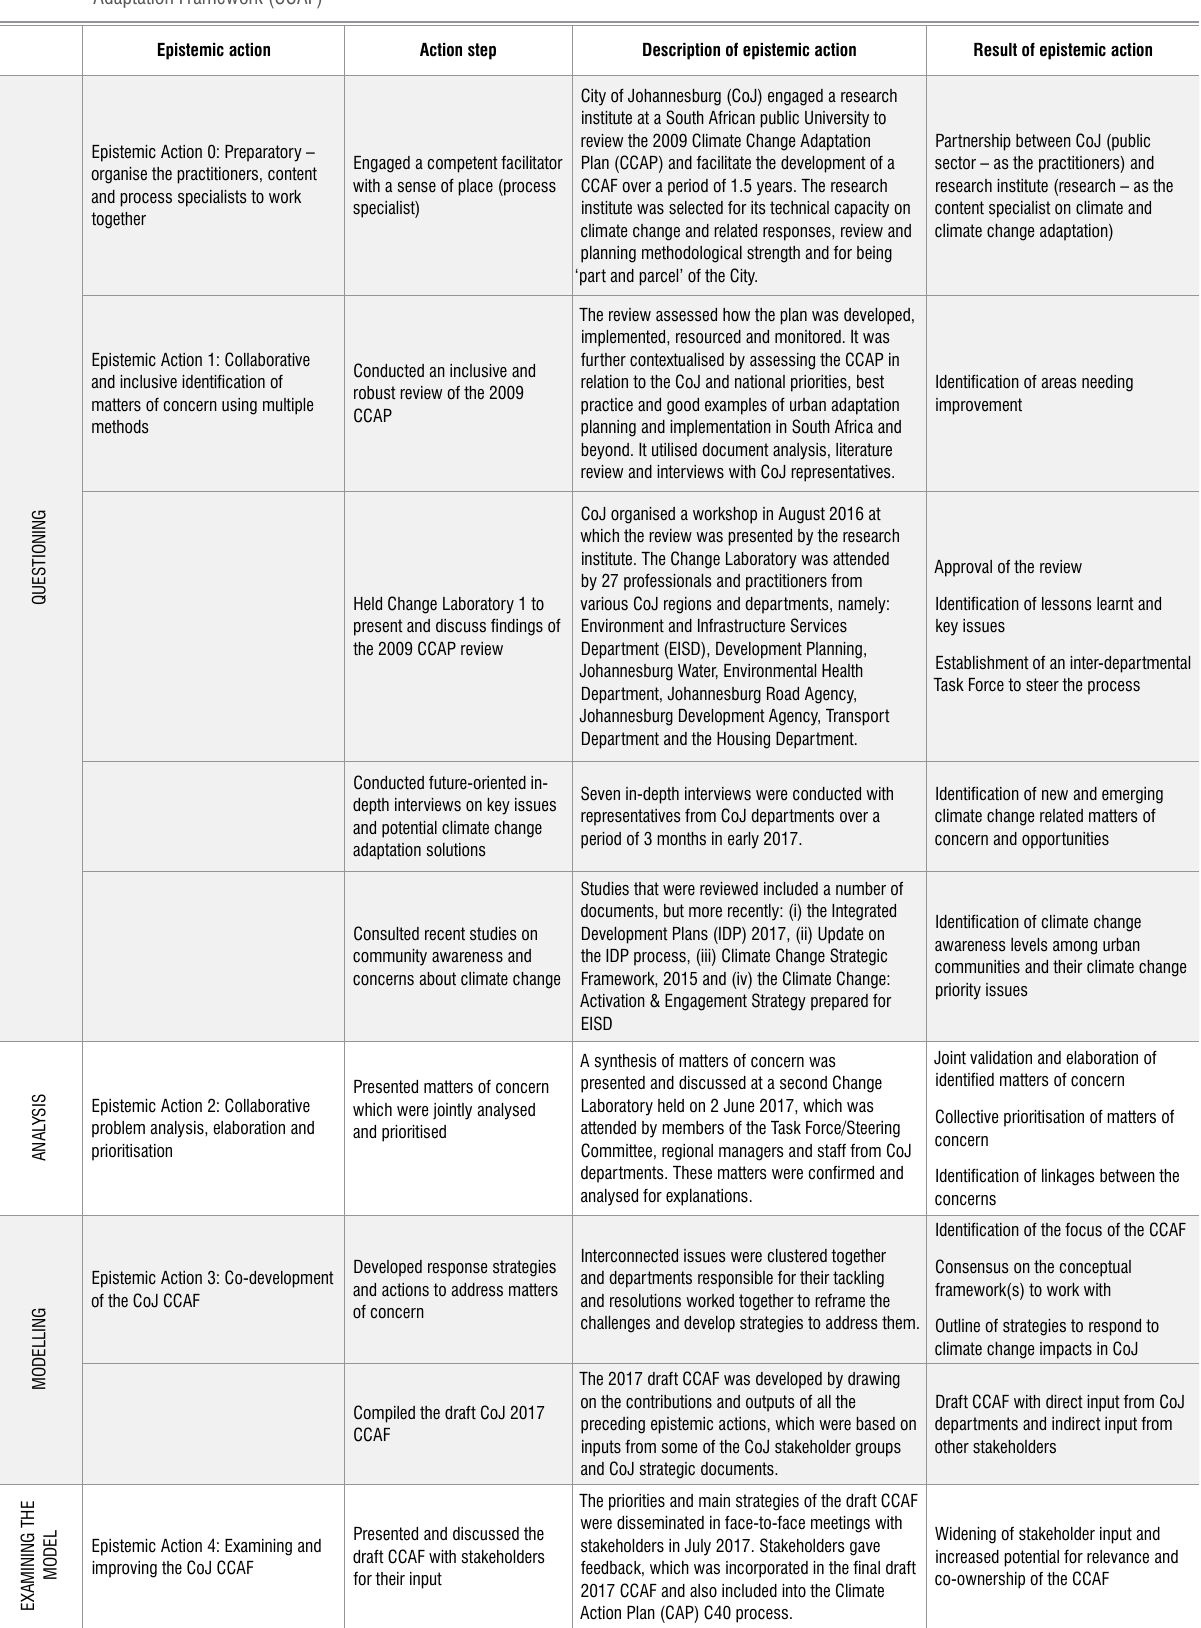
Table 1: Sequence and description of epistemic actions in the conceptualisation and development of the City of Johannesburg’s (CoJ) Climate Change Adaptation Framework (CCAF) Epistemic action Action step Description of epistemic action Result of epistemic